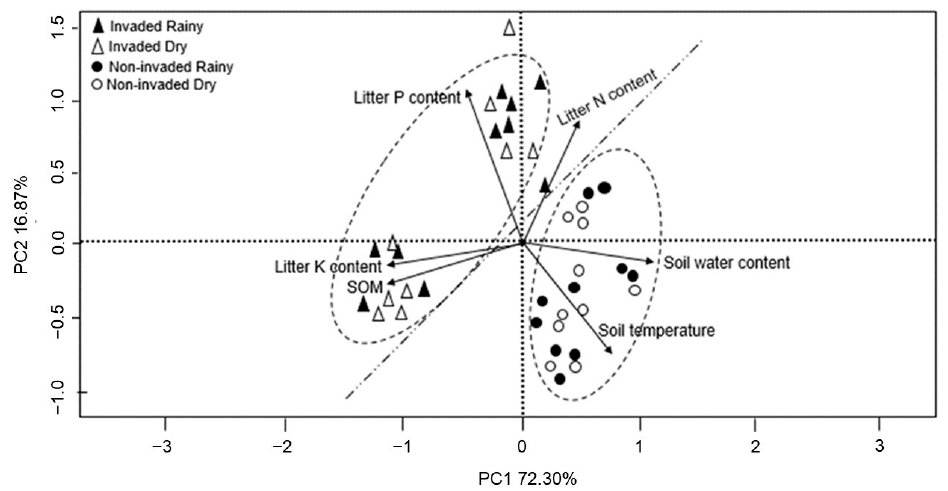
Figure 3. PCA score plot of litter quality and soil properties in the invaded and non-invaded environments during rainy and dry seasons. Triangles and points represent samples from each plot by the invaded and non-invaded environment, respectively. The two axes represent 89.17% of the data variance.